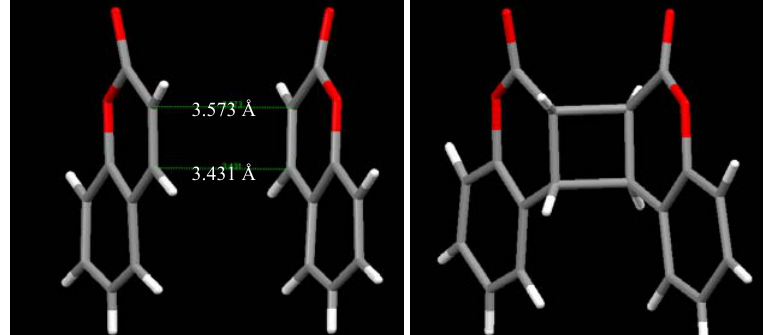
Figure 3. Mutual orientation of coumarin (left) and the anti–head–head dimer (  )- 2 (right) in the inclusion complex with (  )- 23